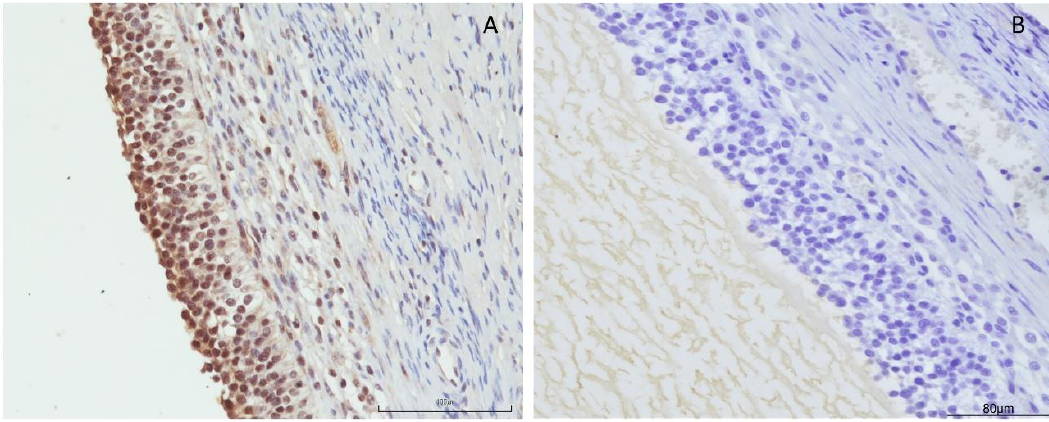
Figure 1. ( A ) Cytoplasmatic positivity for orexin B in granulosa cells (20X IHC). Scale bar = 100 µm. ( B ) Negative control. OXB did not affect either granulosa cell viability or granulosa cell proliferation at the